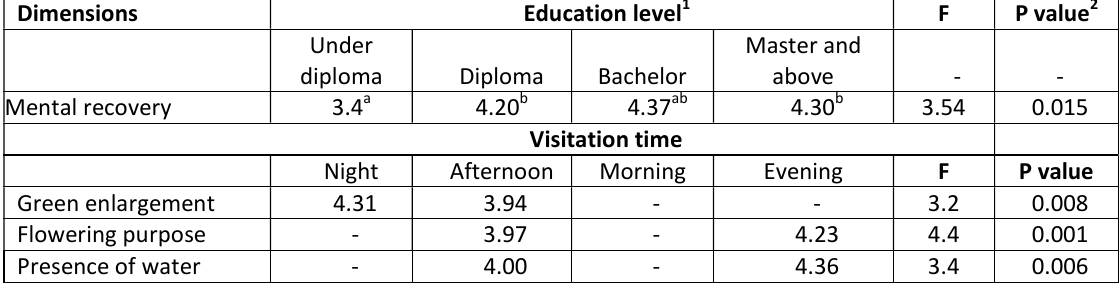
Table 6: Using One-way ANOVA for Education Level and Visitation Time into Preference